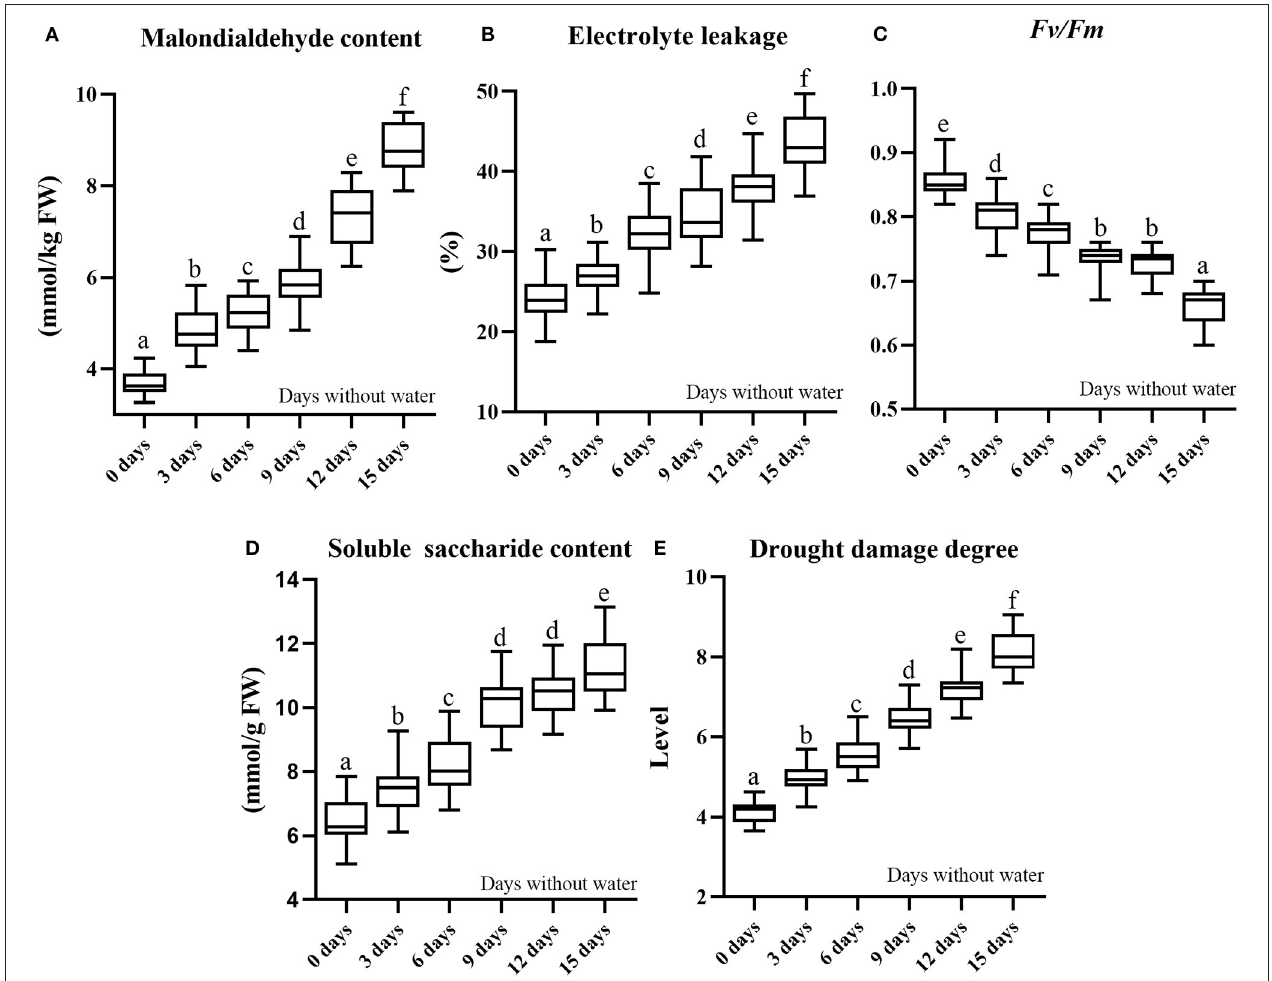
FIGURE 2 | Data distribution of drought-induced components (three repeats) and damage degree of six periods under drought stress (boxplot) (A) . Malondialdehyde content; (B) . electrolyte leakage; (C) . Fv/Fm ; (D) . soluble saccharide content; (E) . drought damage degree. The data box in the figure below different letters are significantly different at P < 0.05 according to Duncan’s